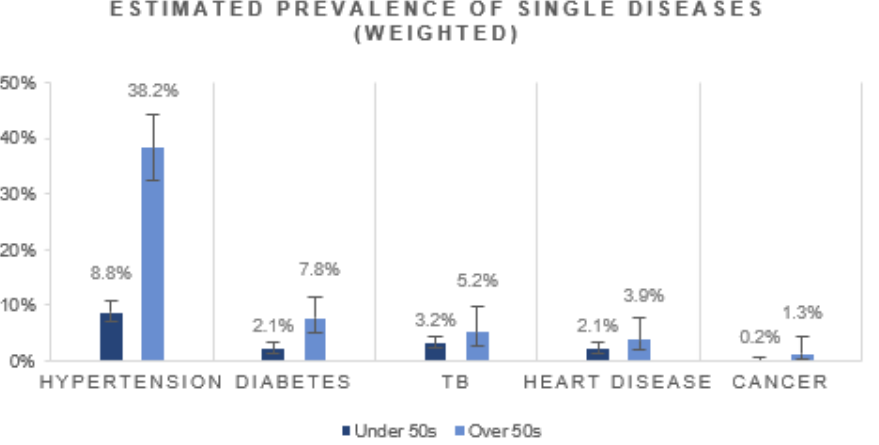
Figure 2. Estimated prevalence of single disease conditions in HIV-positive people by age group.